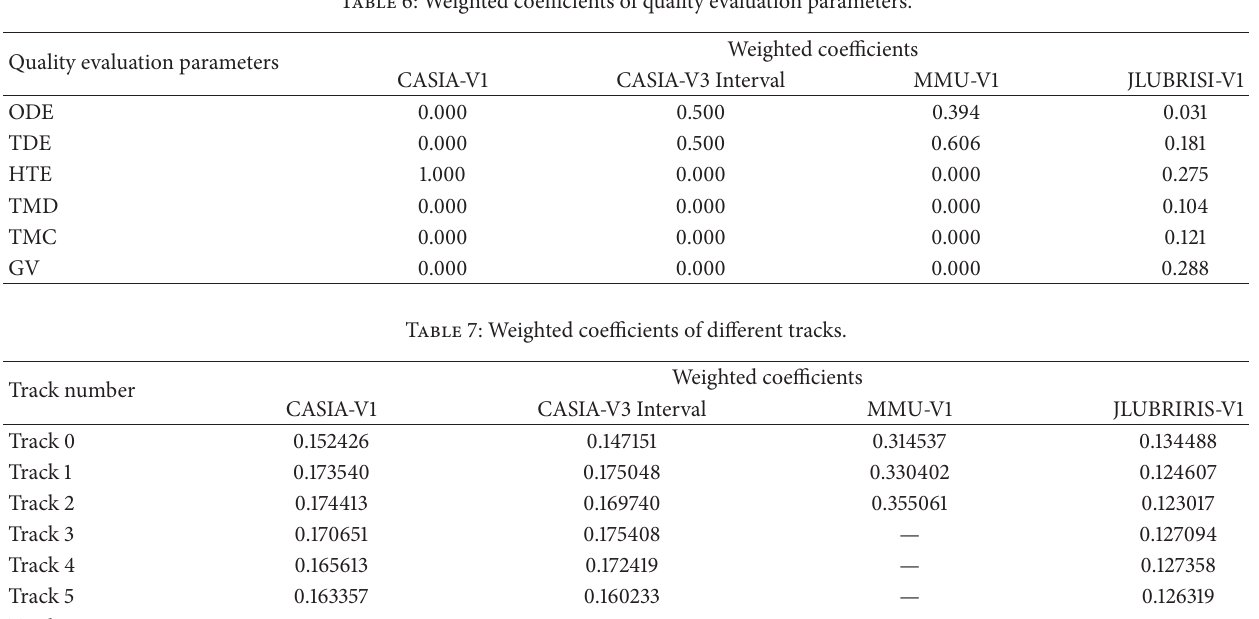
Table 6: Weighted coefficients of quality evaluation parameters.